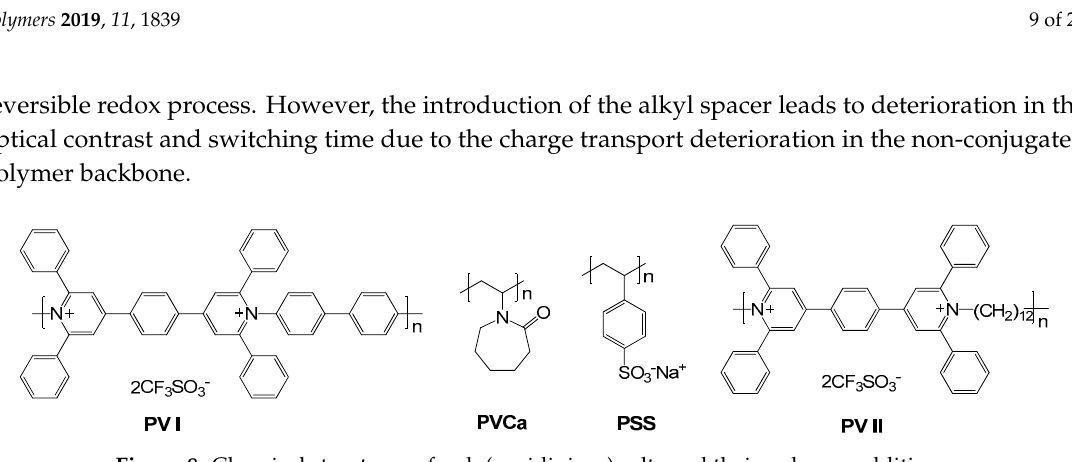
Figure 8. Chemical structures of poly(pyridinium) salts and their polymer additives.